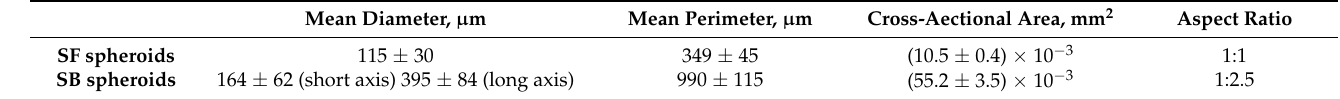
Figure 2. Measurement of total ATP amount in SF and SB A549 spheroids at different time points. ATP content correlates with viable cell number and reflects spheroid growth rate. Data are shown as means ± SD ( n = 4–5). * p < 0.05 (Mann–Whitney U test). 2.2. Drug Resistance Analysis of A549 Cells in Monolayers, SF and SB A549 Spheroids It was revealed in several studies that aggregation of cancer cells, including A549, into spheroids increases their resistance to anti-cancer drugs and nanotherapeutics [9–11]. Here, we observed the same phenomenon for A549 spheroids, which demonstrated en- hanced drug resistance to five different chemotherapeutics in comparison with A549 cells grown in a monolayer (2D) (Figure 3A–E). In particular, the samples of SF A549 spheroids